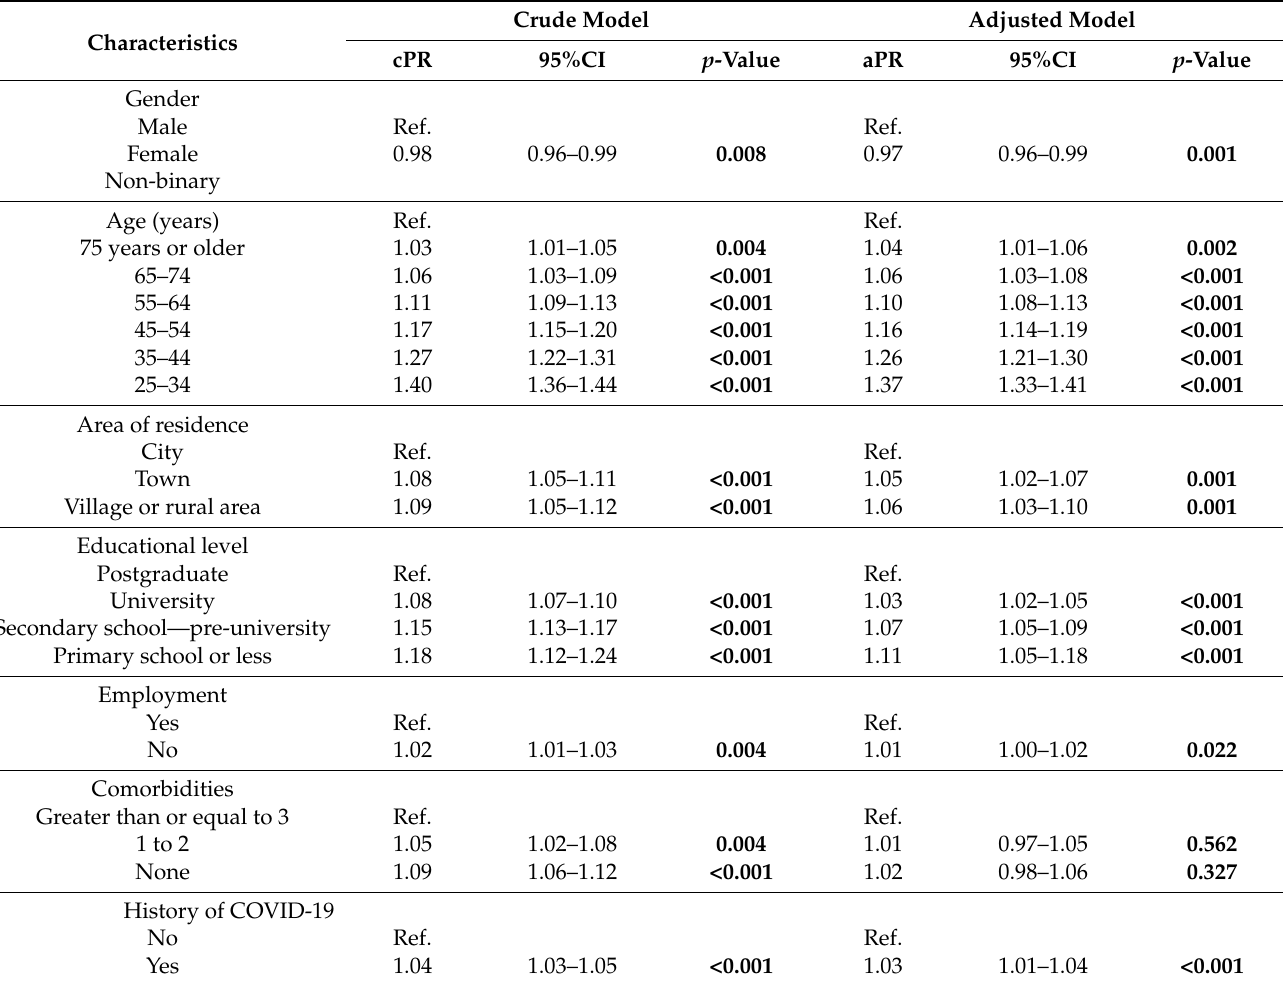
Table 3. Factors associated with not having received a booster dose of the COVID-19